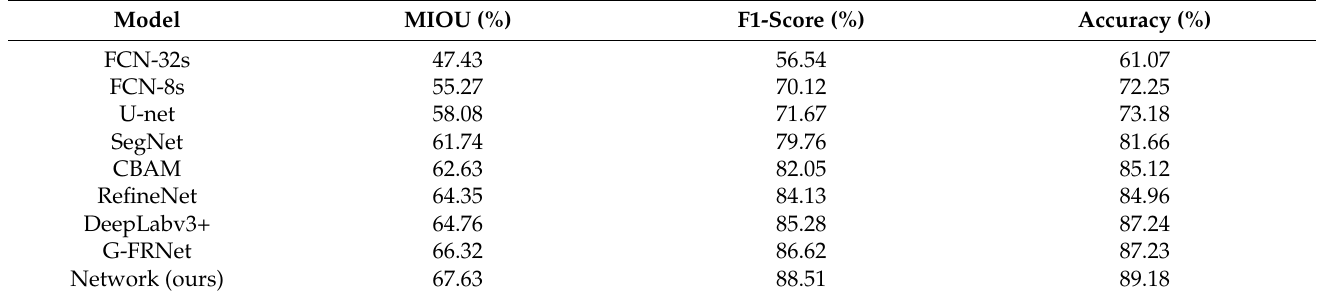
Table 2. Semantic segmentation results of short-grain rice dataset. The index results of MIOU, F1-score and accuracy of each algorithm.